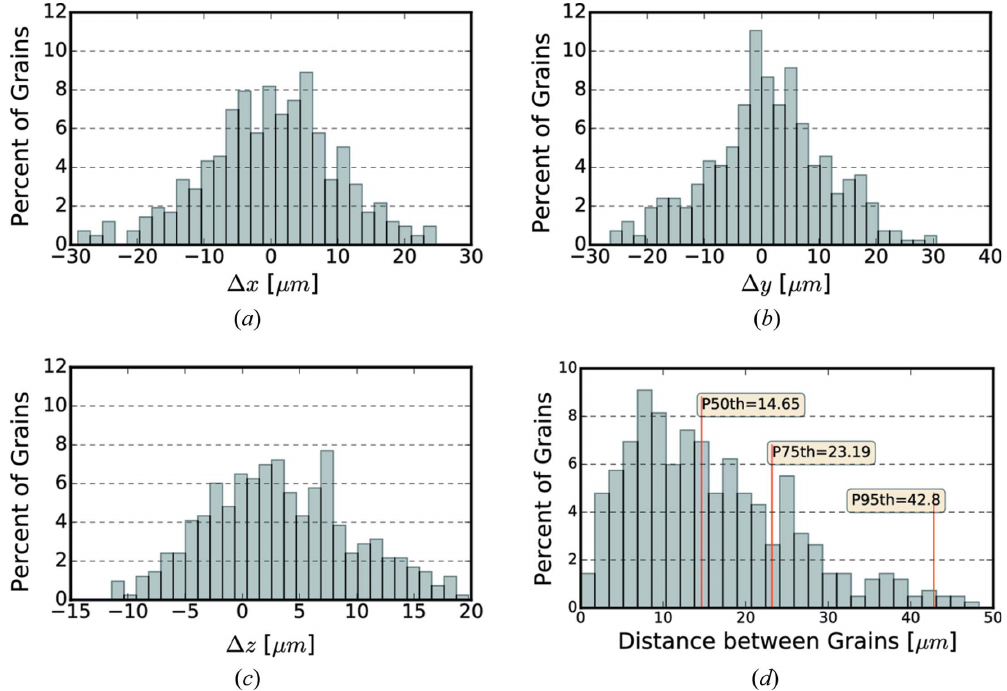
Figure 5 Distribution of position differences between grains when reconstructed using the BraggNN peak position and by pseudo-Voigt fitting: ( a ) x axis, ( b ) y axis, ( c ) z axis, ( d ) Euclidean distance. P n in ( d ) denotes the n th